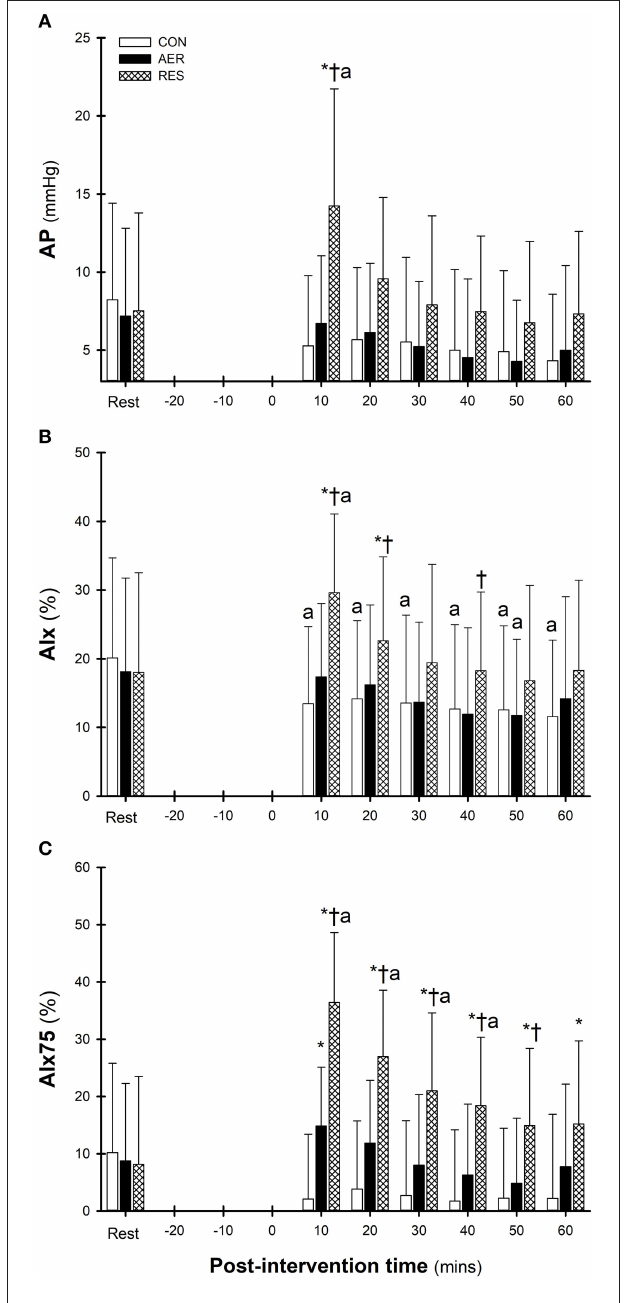
FIGURE 2 | Augmentation pressure (AP, A ), augmentation index (AIx, B ), and augmentation index corrected to a heart rate of 75 (AIx75, C ) at Rest and throughout the post-intervention. Data are presented as mean ± SD. a p < 0.05 significantly different to REST within intervention; * p < 0.05 significantly † p < 0.05 significantly different different to CON (intervention-time interaction); to AER (intervention-time